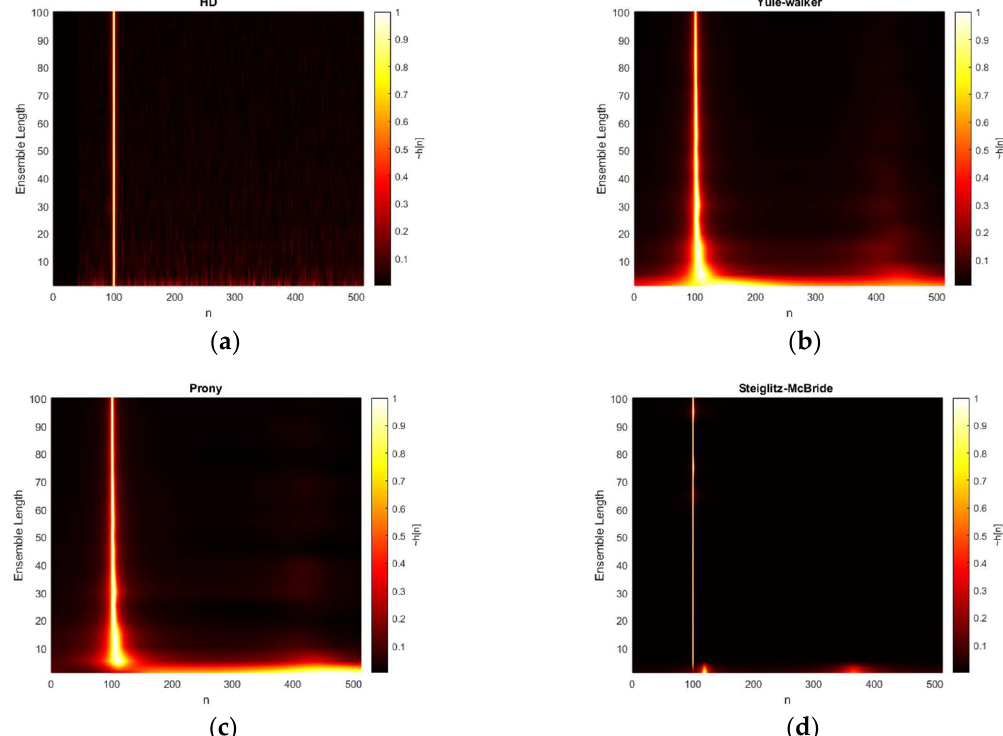
Figure 10. Estimated ℎ(cid:3560)[𝑛] distribution (normalized) with given ensemble average length & 20 dB SNR from: ( a ) non-parametric HD top-view (interpolated); ( b ) Yule-walker HD top-view (interpolated); ( c ) Prony HD top-view (interpolated); ( d ) Steiglitz-McBride HD top-view (interpolated).